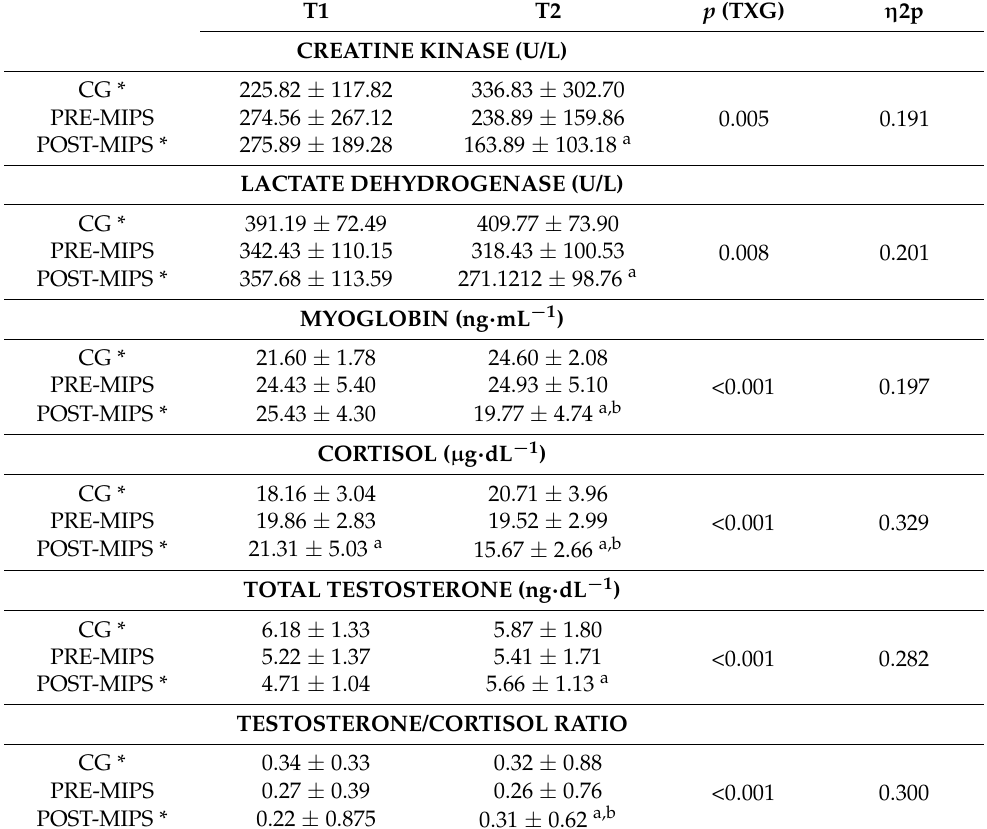
Table 3. Behavior of muscle damage and muscle recovery in the 3 study groups at the beginning and end of 10 weeks of